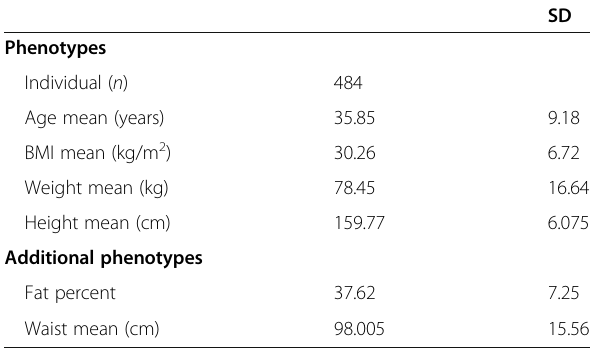
Table 1 Baseline phenotypes and rs6265 (Val66Met) genotype distribution of